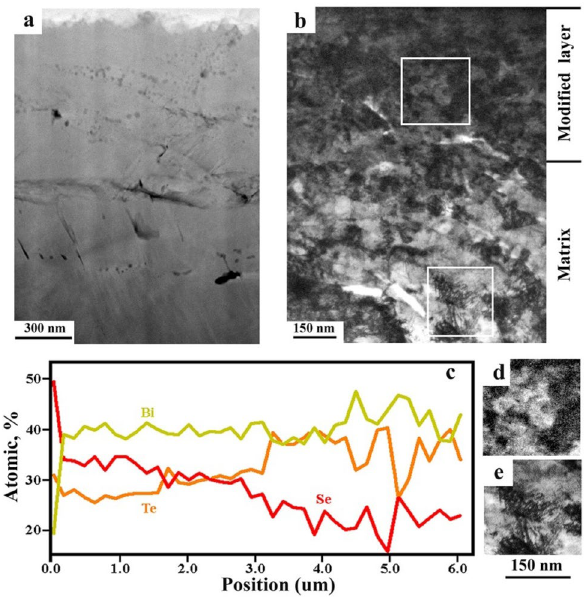
Fig. 5 The cross-sectional STEM ( a ), TEM ( b ) images and the con- centration profiles of elements ( c ) after the double PT ( E I ~ 140 J/ cm 2 ). The enlarged fragments of STEM, TEM images are shown in figures d and